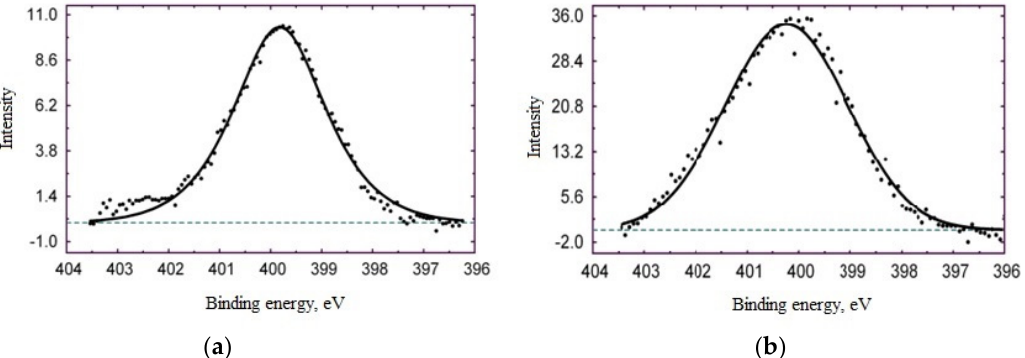
Figure 5. XPS N1s spectra of BTA sodium salt ( a ) and BTA molecules adsorbed on iron ( b ).